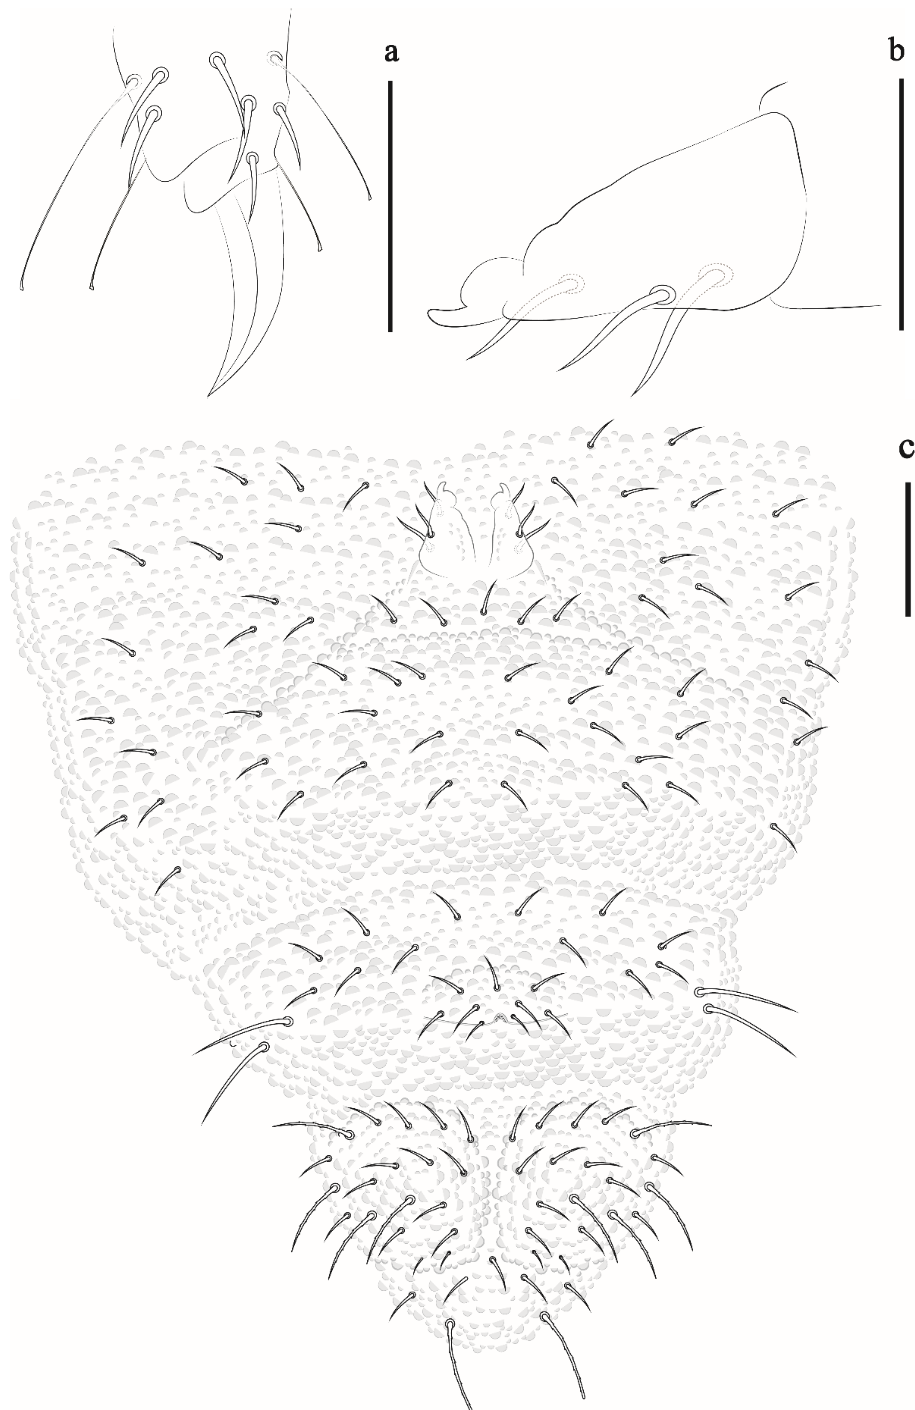
Figure 6. Friesea noronhaensis sp. nov. ( a ) Tita III, scale bar: 10 µm. ( b ) furca, scale bar: 10 µm. ( c ) ventral view of abdominal segment II–VI, scale bar: 20 µm. Distribution . Friesea noronhaensis sp. nov. is registered only in the Fernando de Noronha Archipelago on Fernando de Noronha Island (SF sites) and Rata Island (SF and TF sites). The specimens were collected in superficial soil and